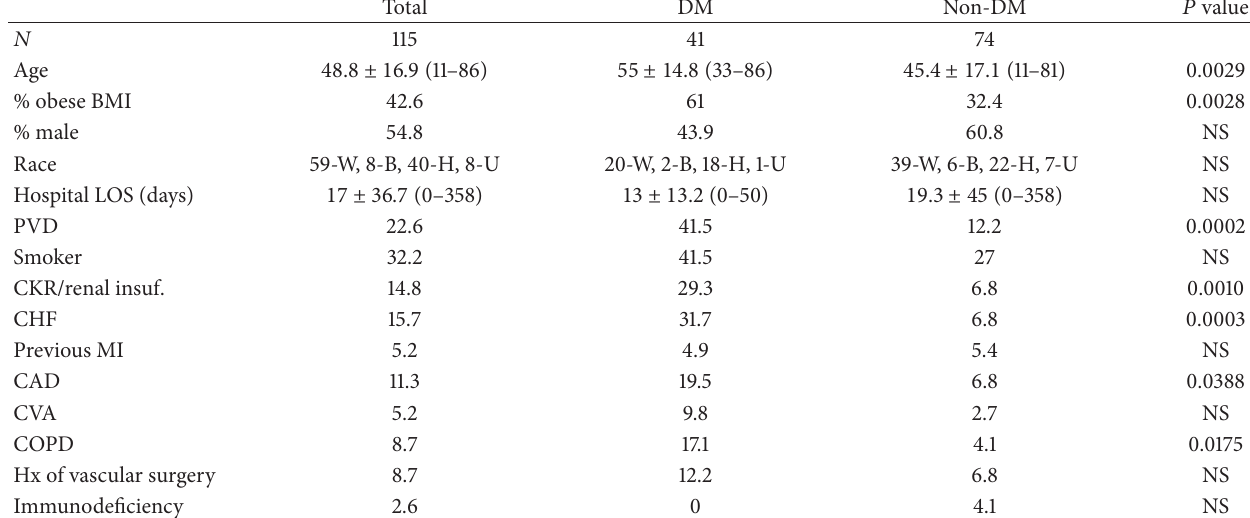
Table 1: Demographics and comorbidities associated with the wound population surveyed.